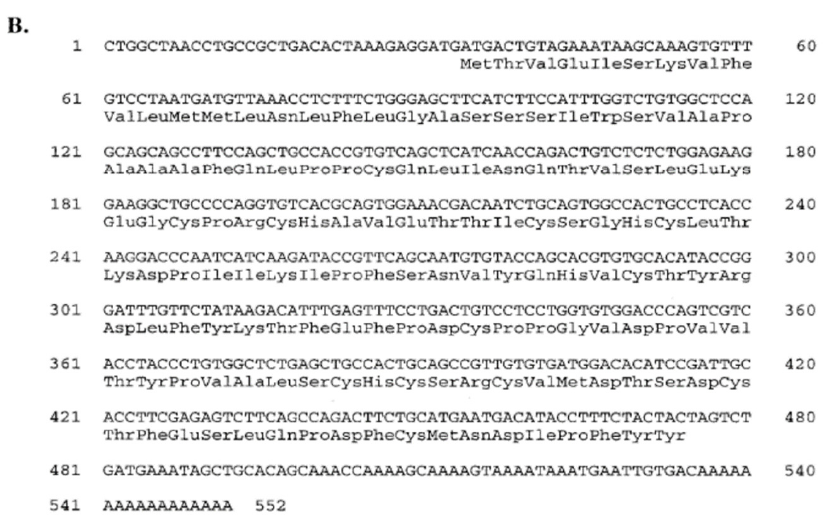
Figure 15. Nucleotide sequences of blue gourami FSH- β ( A ) and LH- β ( B ). The amino acid sequence. of each hormone appears in three-letter code. The GenBank accession numbers of these sequences are AF157630 and AF157631, respectively [34].